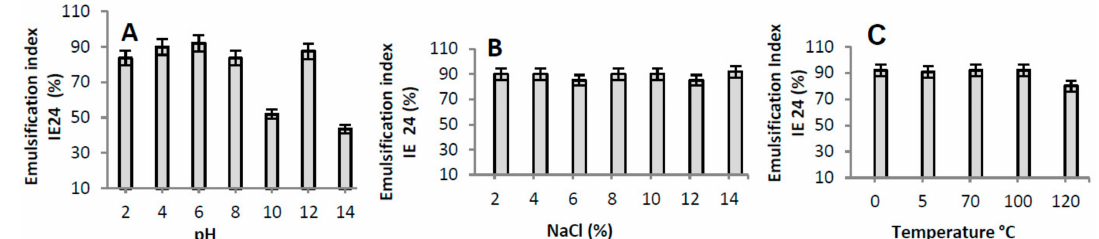
Figure 3. The stability of the bioemulsifier that was produced by Bacillus subtilis UCP 0146 according to the emulsification index (EI 24 ): pH ( A ); NaCl ( B ); and temperature ( C